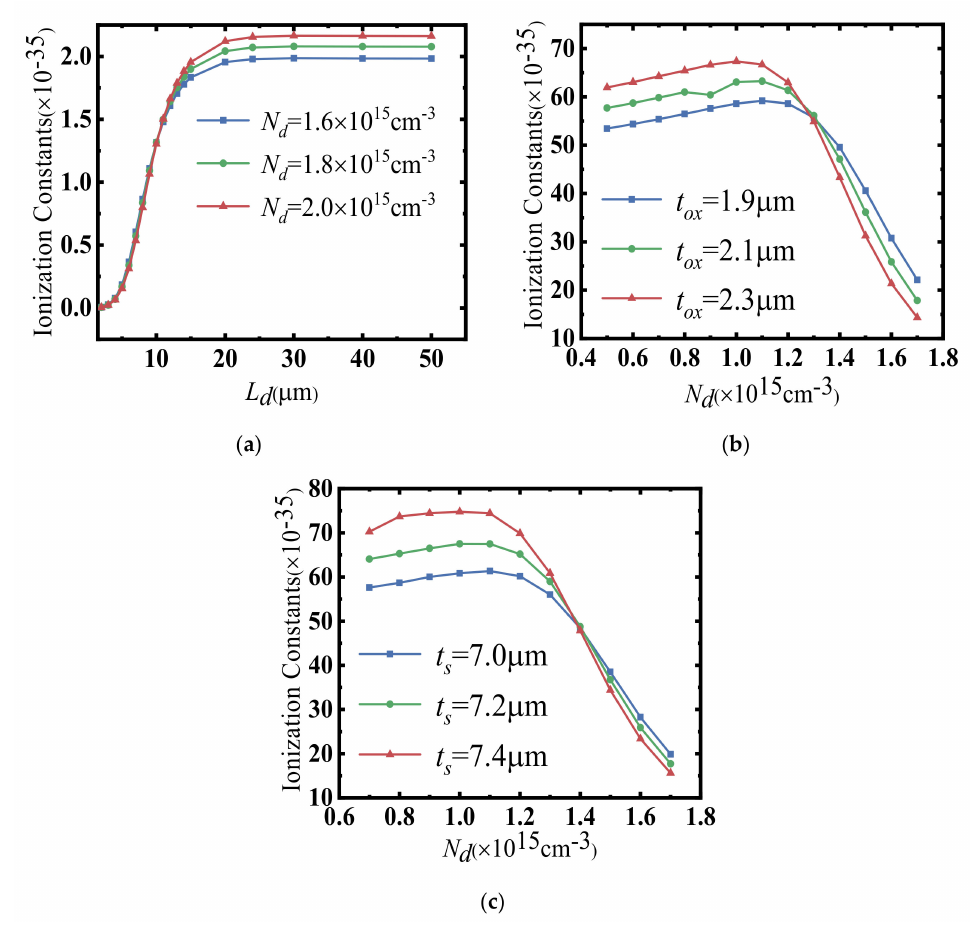
Figure 4. ( a ) Variation curves of a 0 with L d and N d for different L d at full depletion of the drift region. ( b ) Variation curves of a 0 with t ox and N d for different t ox at full depletion of the drift region. ( c ) Variation curves of a 0 with t s and N d for different t s at full depletion of the drift region.